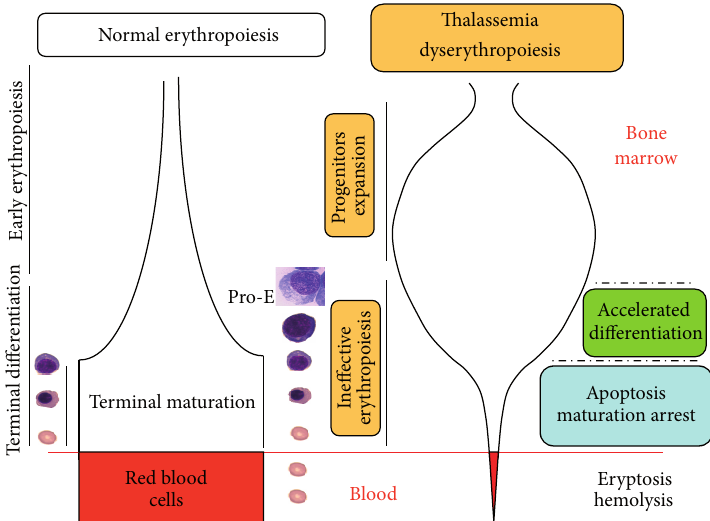
Figure 1: Difference between normal and 𝛽 -thalassemia ineffective erythropoiesis. Erythropoiesis is the pathway producing mature RBCs from hematopoietic stem cells, including several proliferation and differentiation steps. Erythroid differentiation is accompanied by temporally regulated changes in cell surface protein expression, reduction in cell size, progressive hemoglobinization, and nuclear condensation and extrusion. 𝛽 -thalassemia dyserythropoiesis in human is characterized by expansion of very early erythroid precursors (proerythroblasts and earlier stages) and then ineffective erythropoiesis. Ineffective erythropoiesis defines the suboptimal production of mature erythrocytes from a proliferating pool of immature erythroblasts characterized by (1) accelerated erythroid differentiation, (2) maturation blockade at the polychromatophilic stage, and (3) death of erythroid precursors.